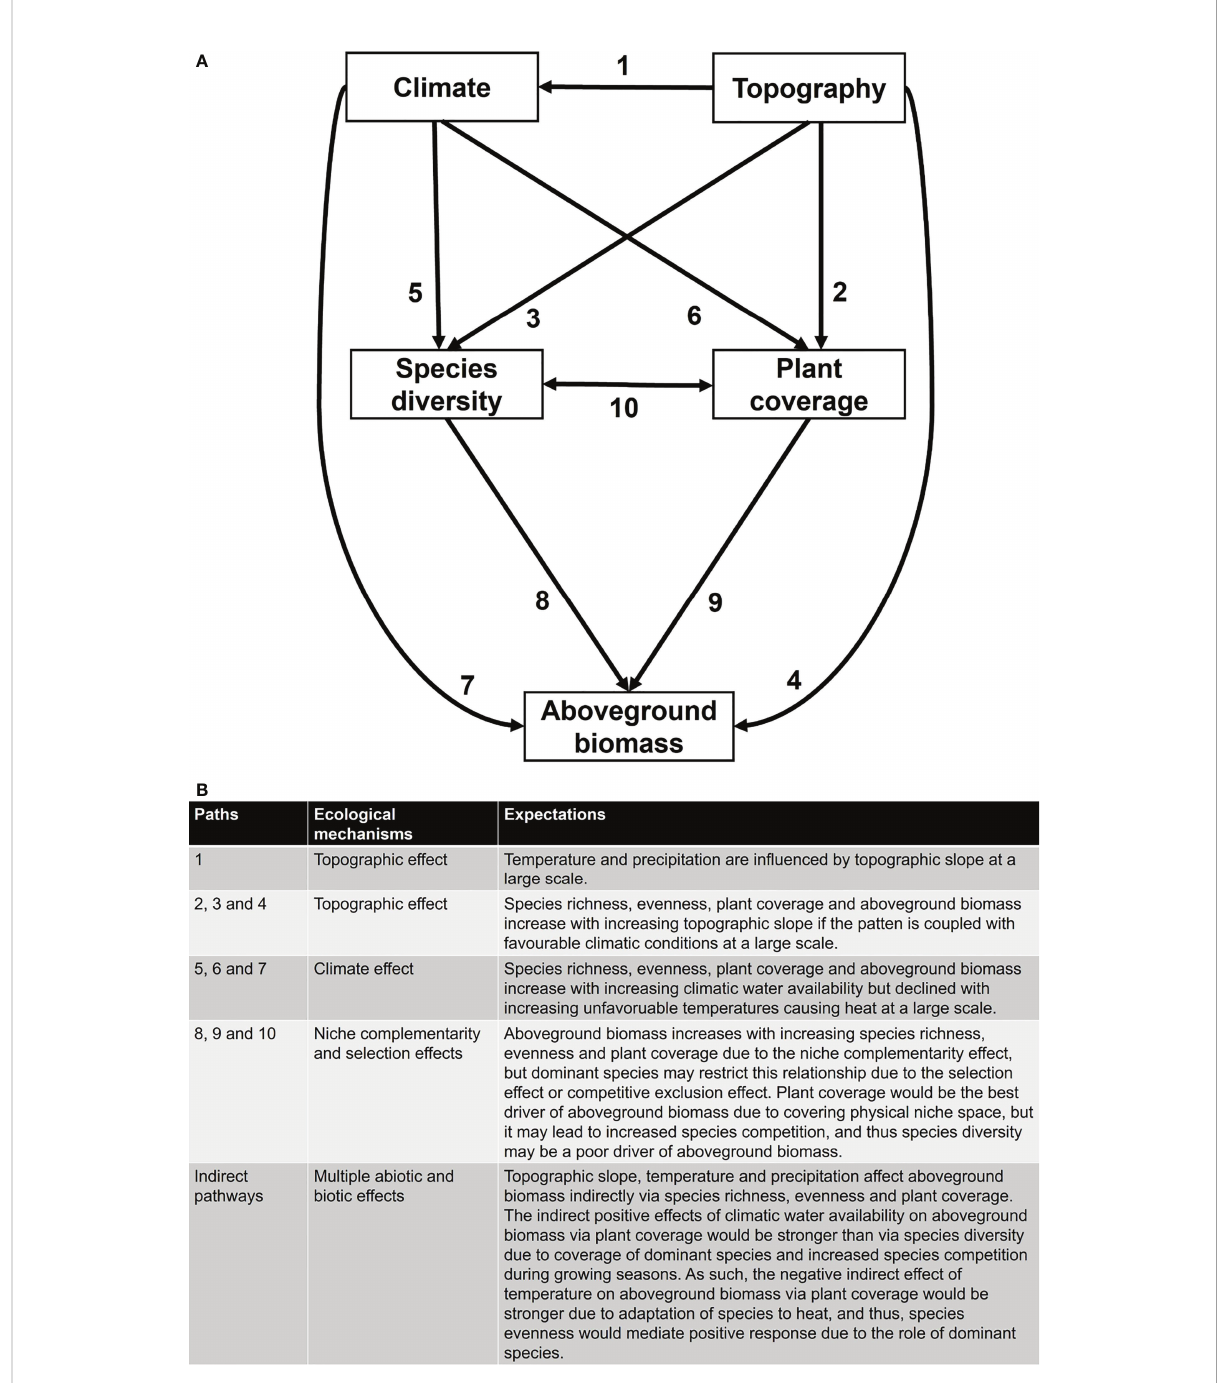
FIGURE 1 The brief conceptual model (A) and explanation of mechanisms and expectations (B) for elaborating the research questions and hypothesis in this study. Composite paths are labelled with numbering (A) for brief explanation (B) . Topography is represented by terrain slope, climate is represented by mean annual temperature (MAT) and mean annual precipitation (MAP), and species diversity is represented by species richness (S) and species evenness